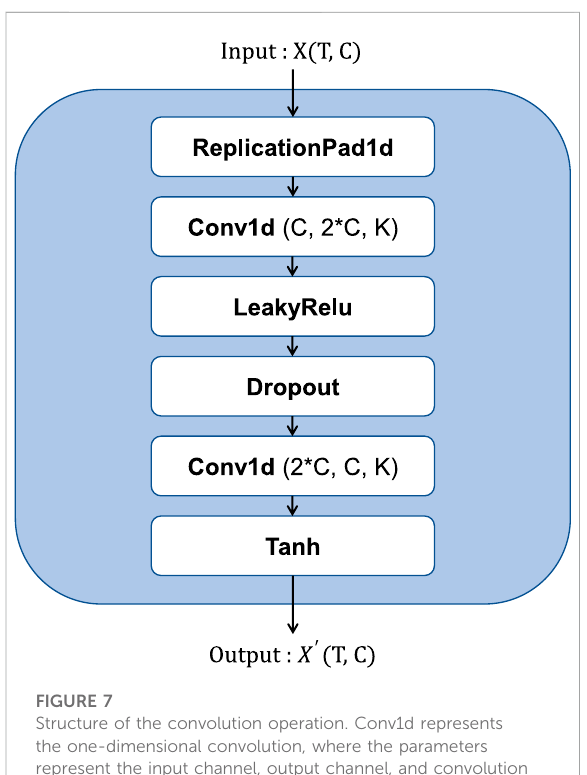
FIGURE 7 Structure of the convolution operation. Conv1d represents the one-dimensional convolution, where the parameters represent the input channel, output channel, and convolution kernel